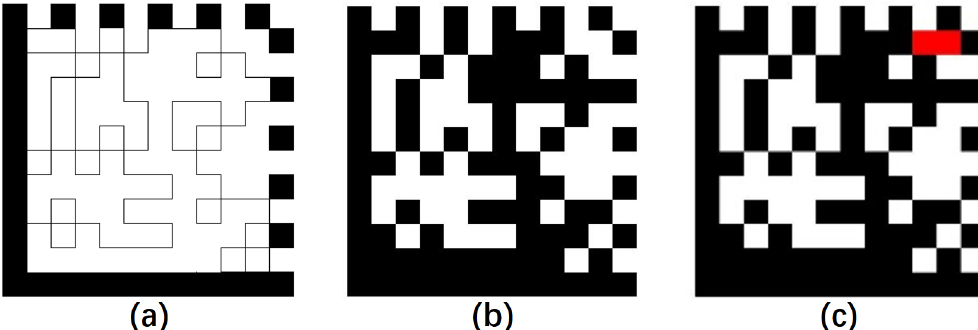
Figure 13. Barcode reconstruction. ( a ) Colors of modules of the Finder Pattern and the Timing Pattern; ( b ) the reconstructed barcode image; ( c ) incorrect modules in the reconstructed barcode image.